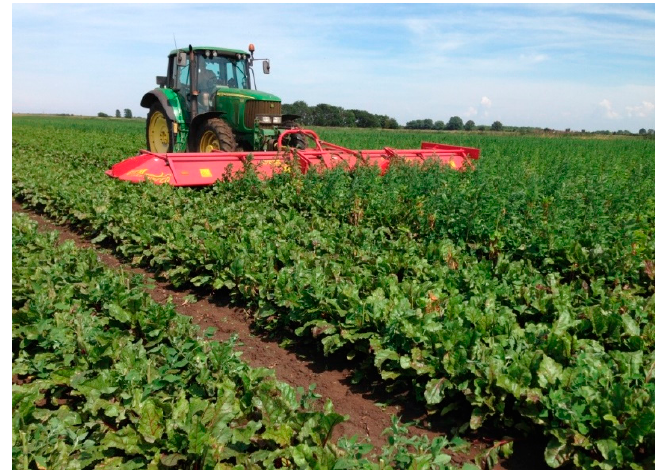
Figure 3. A weed header (Weed Surfer) in action topping weed seed heads protruding above an organic beetroot ( Beta vulgaris L.) crop (Photo: S Briggs).